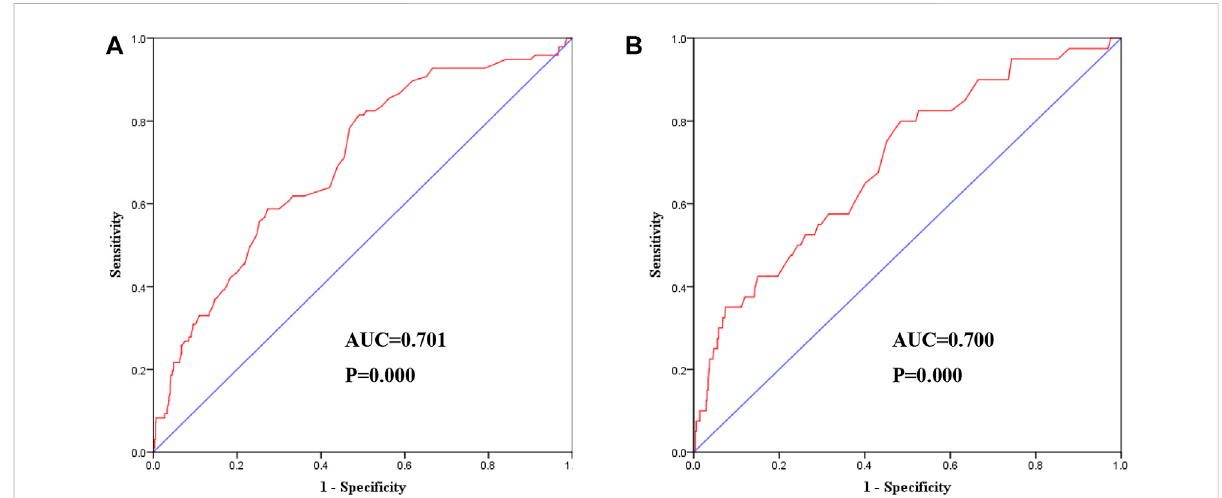
FIGURE 7 Receiver-operatingcharacteristiccurveshowedtheperformanceofCys-Cinpredictingahighriskofclinicaloutcomes. (A)